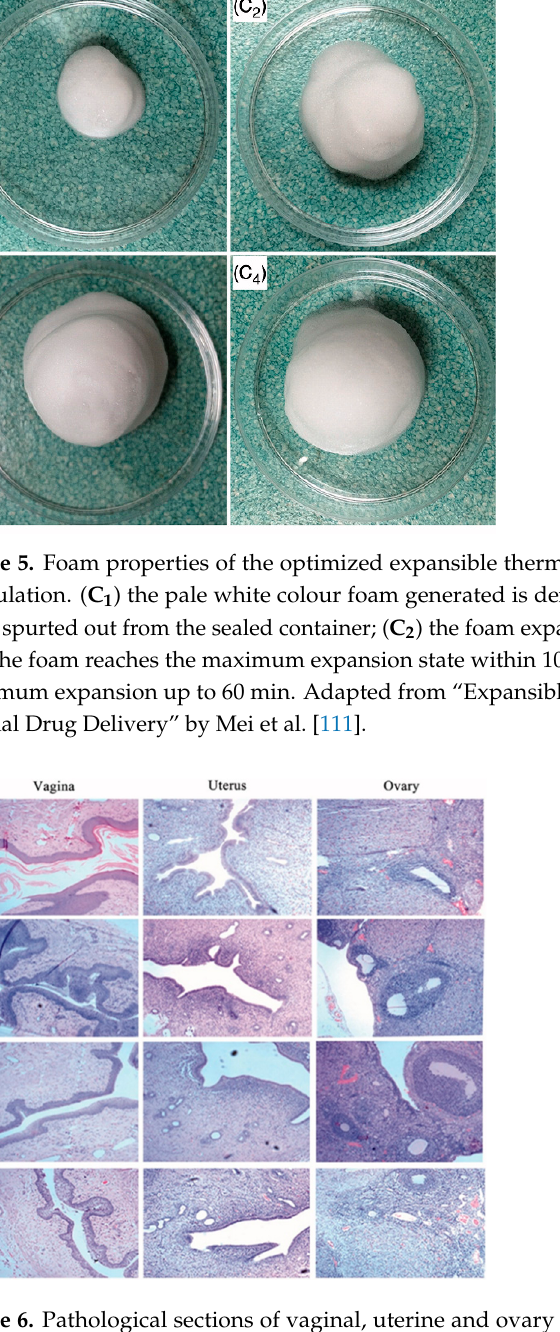
Figure 6. Pathological sections of vaginal, uterine and ovary tissues of Sprague Dawley (SD) rats. (Hematoxylin and Eosin (HE) staining, ×400). ( A ) for blank saline, the vaginal epithelial tissue and uterine endometrium are intact; ( B ) for blank ETGFA, hyperkeratosis of vaginal epithelial tissue and slight uterine eosinophilic infiltration are observed; ( C ) for silver nanoparticle-loaded ETGFA, hyperkeratosis of vaginal epithelial tissue, slight uterine eosinophilic infiltration and local infiltration of lymphocytes are observed; and ( D ) for silver nanoparticle solution, severe tissue irritation is observed. Reproduced with permission from “Expansible Thermal Gelling Foam Aerosol for Vaginal Drug Delivery” by Mei et al. [111].